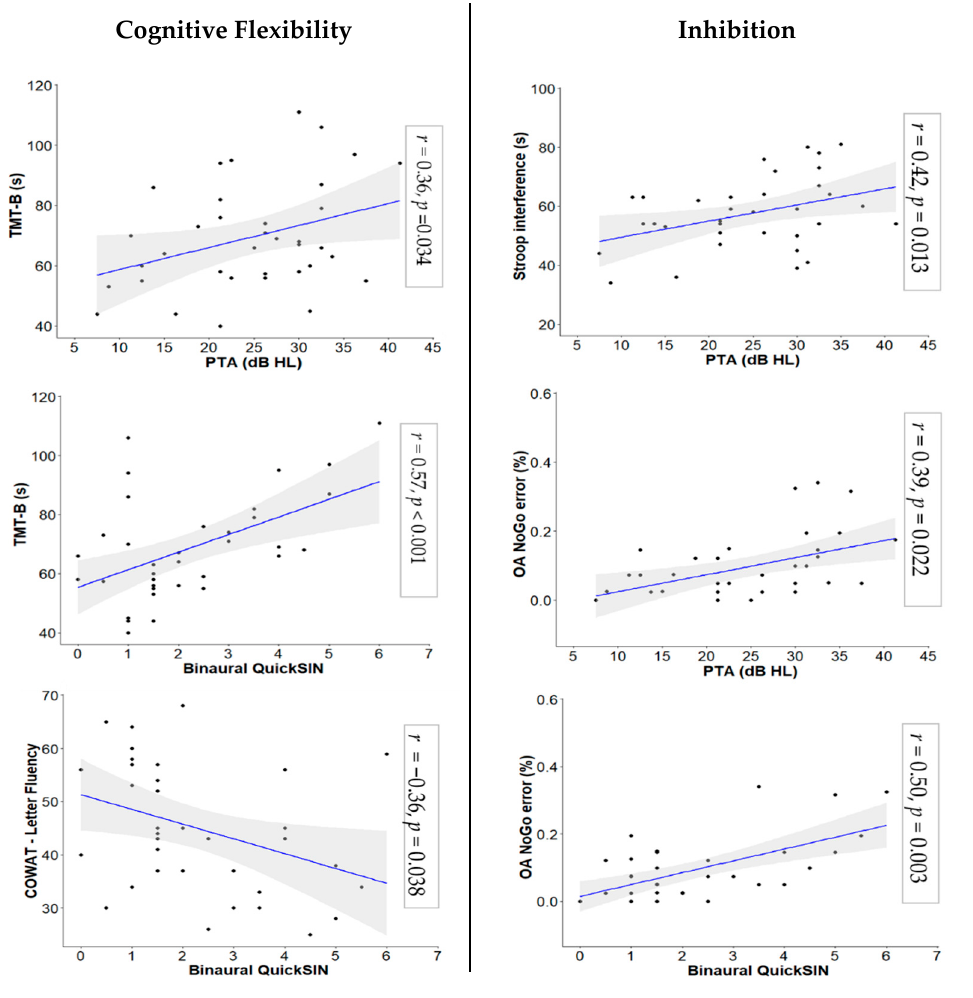
Figure 2. Significant Relationships between Hearing and Cognitive Control Variables. PTA (dB HL) = Pure-Tone Average (decibels hearing level); QuickSIN = Quick Speech-in-Noise [68]; TMT-B = Trail Making Test B [71]; COWAT = Controlled Oral Word Association Test [70]; OA = Object-Animal Task. Table 4. Correlations between Hearing and Cognitive Control Measures.